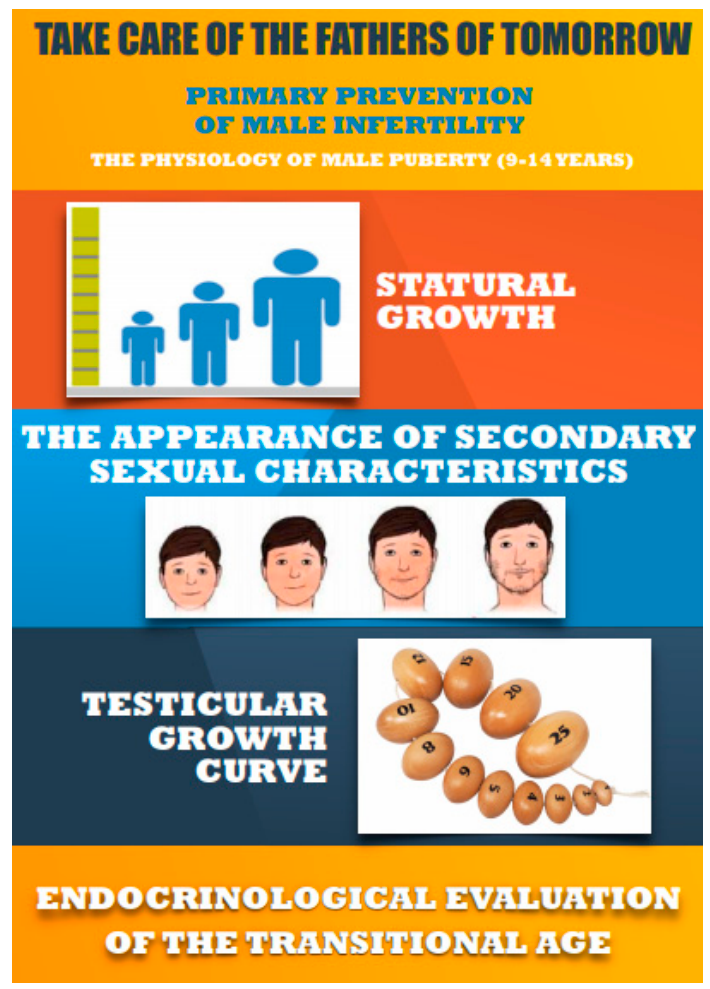
Figure 1. Primary prevention of male infertility. The importance of the testicular volume.